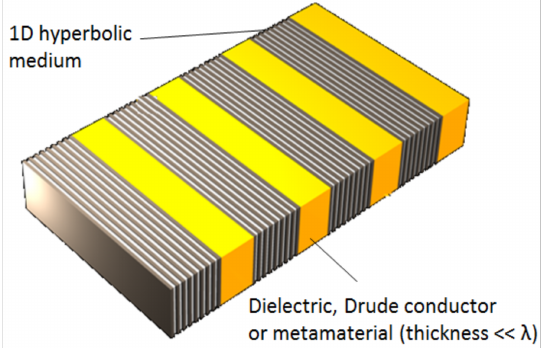
Figure 11. Hypercrystal metasurface containing hyperbolic metamaterial